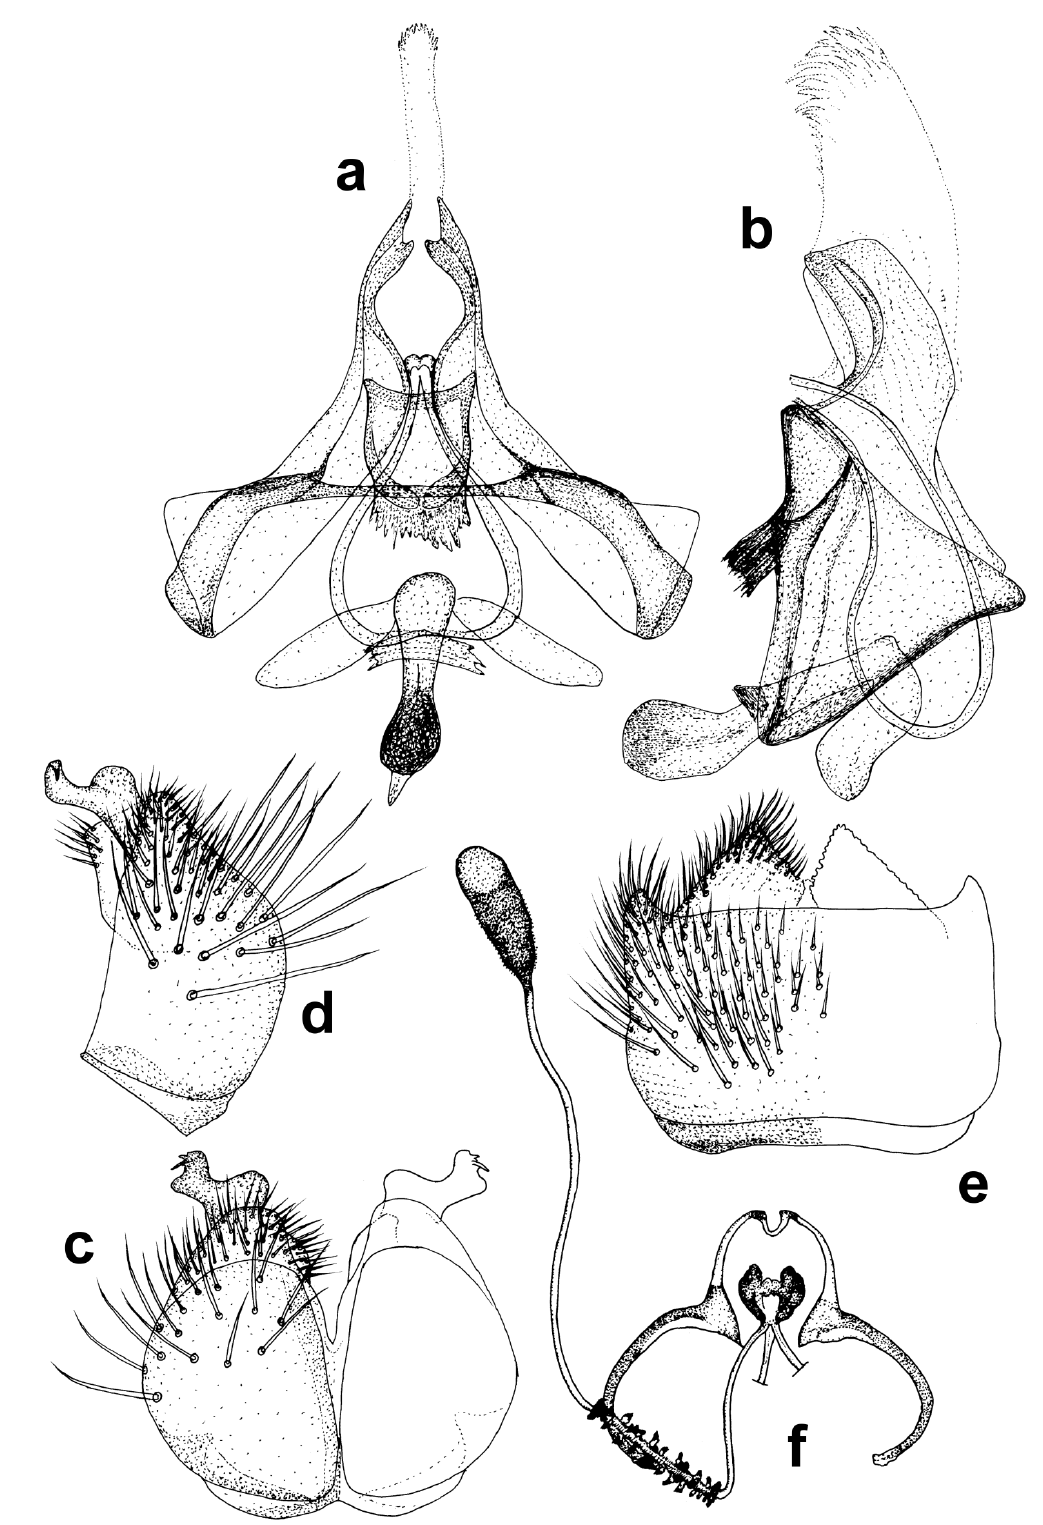
Fig. 58. Protypusia vagans (Becker, 1906) gen. et comb. nov. a . Epiphallic complex ventral. b . Epiphallic complex lateral. c . Gonocoxite ventral. d . Gonocoxite lateral. e . Epandrium dorsal. f . Female genitalia